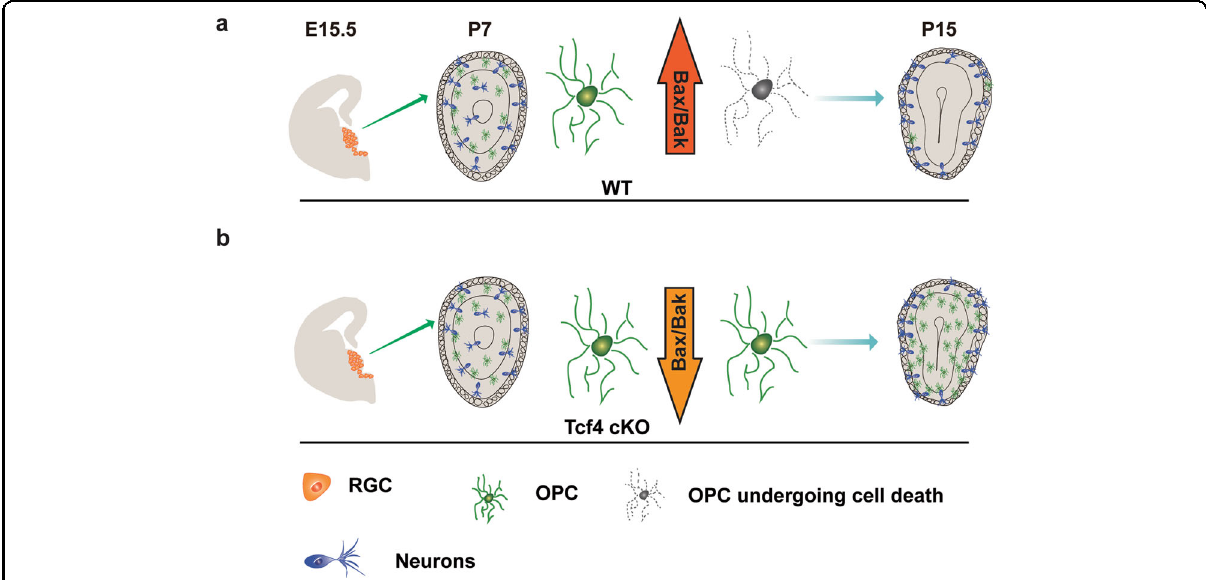
Fig. 8 A model that illustrates how the OPC number is controlled by Tcf4 mediated cell death. a MGE- and AEP-derived OPCs undergo cell death through Bax/Bak pathway after the fi rst postnatal week. b However, when Tcf4 is removed, the downregulation of Bax/Bak leads to an increase of OPC